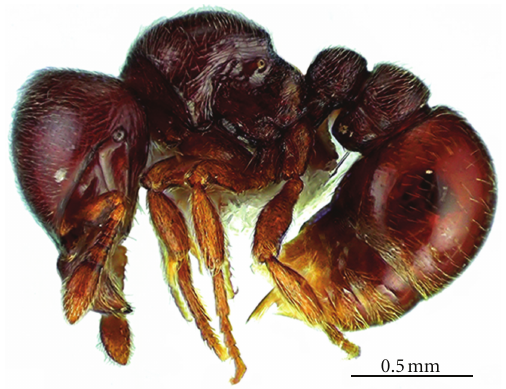
Figure 1: Tatuidris kapasi : holotype worker. Habitus: left lateral view.